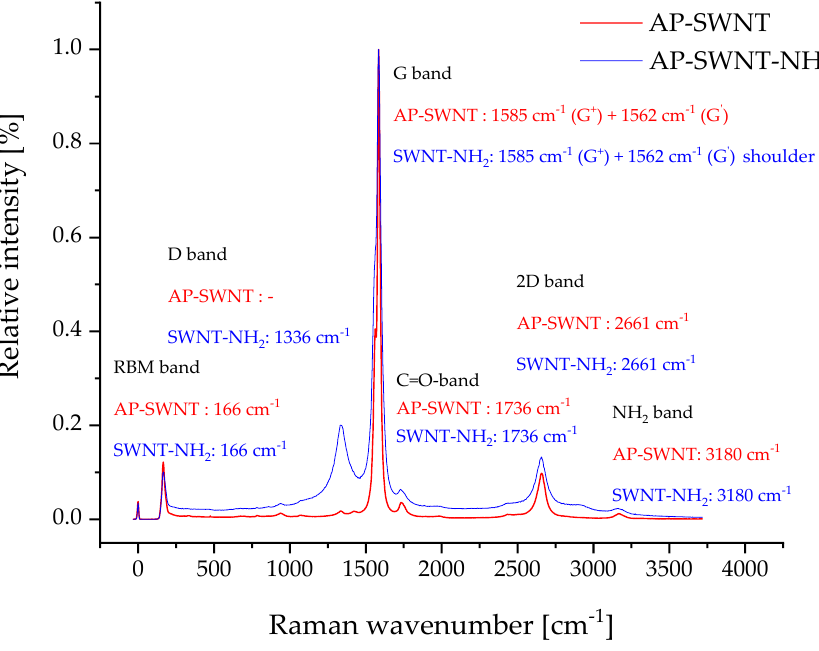
Figure 10. Comparison of Raman spectra of AP-SWNT and AP-NH 2 -SWNT materials, both normalized to the G-band.